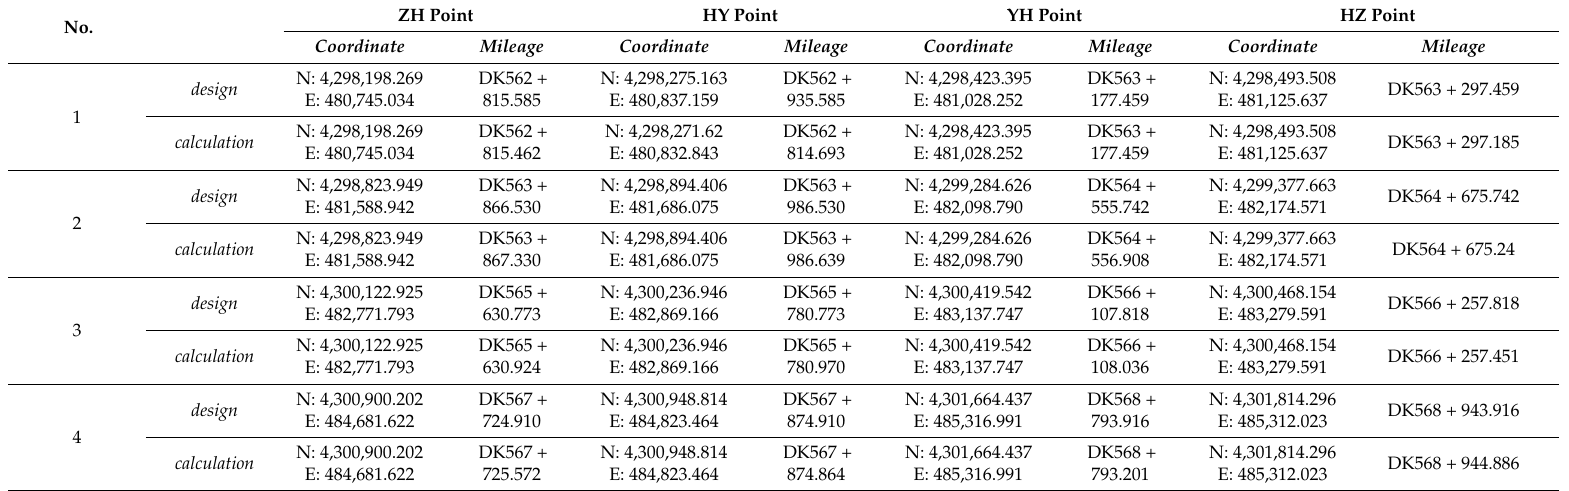
Table 2. The calculation results of the main stake compared with the design data